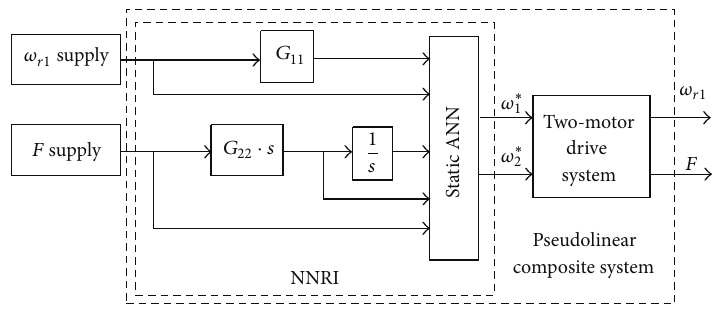
Figure 4: NNGI open-loop control